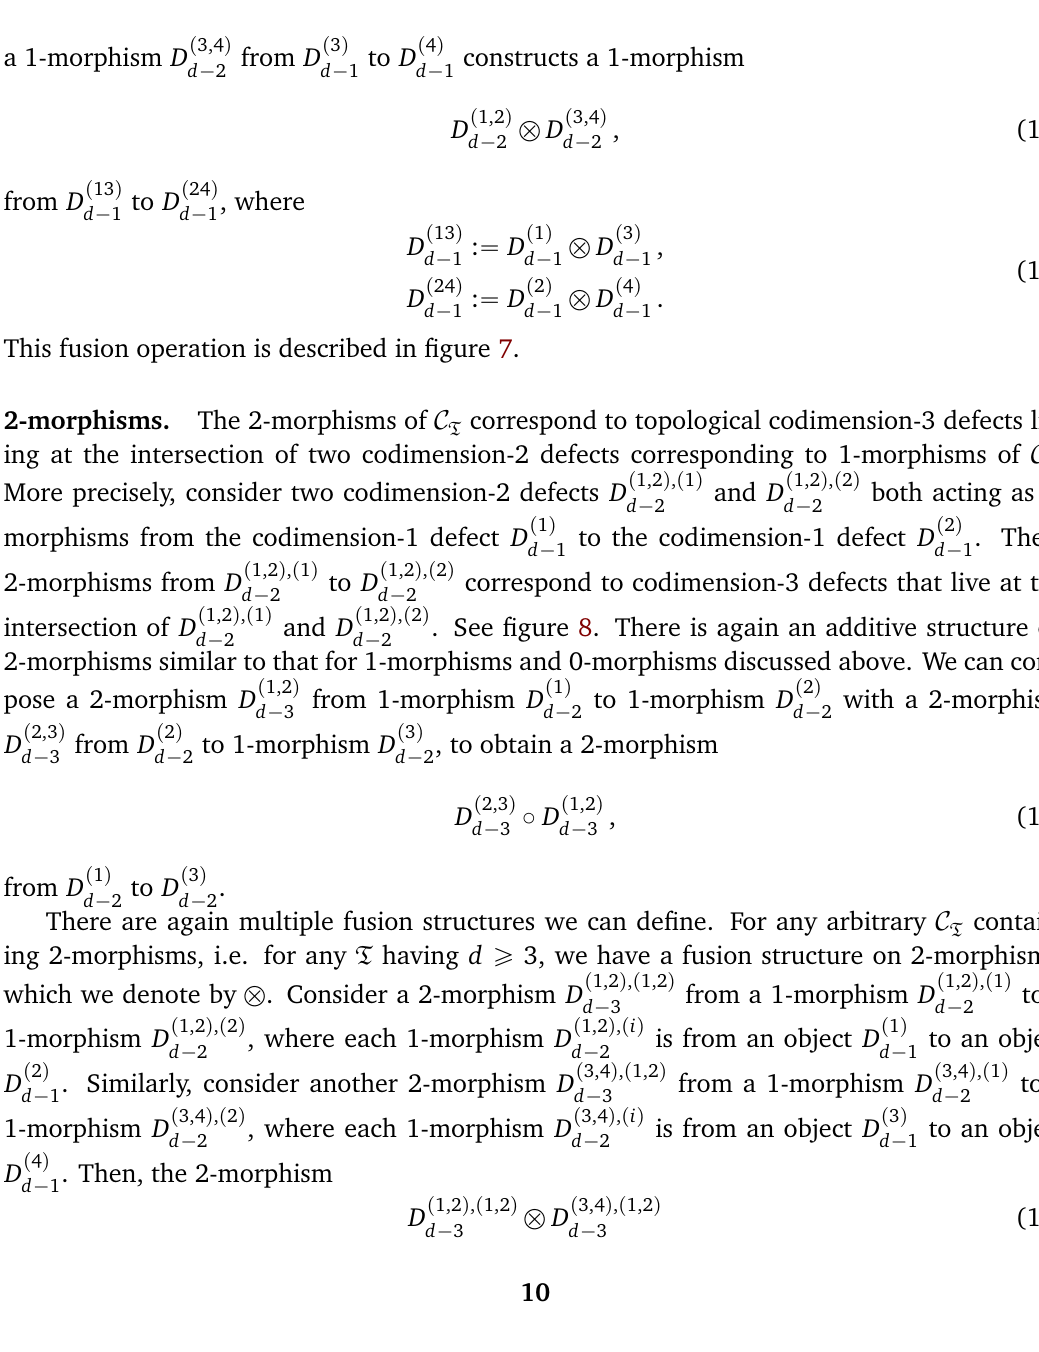
Figure 7: The fusion structure b on general codimension-2 topological